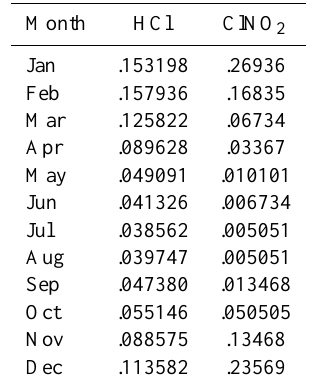
Table A4. Monthly allocation factors applied to the GEIA RCEI (Reactive Chlorine Emissions Inventory) to produce monthly HCl and ClNO 2 emissions from annual totals. Factors in this table may not sum to one due to